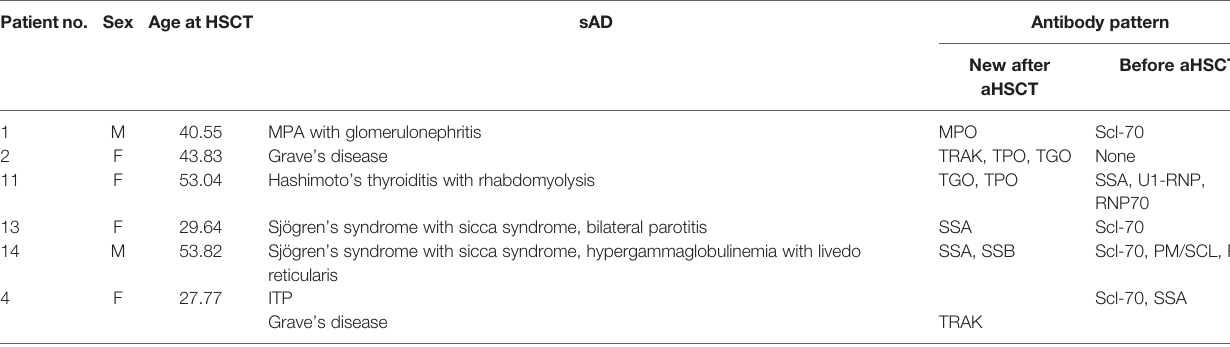
List of all patients with secondary autoimmune disorders sorted by sex, age at transplantation, mRSS before HSCT, new detected autoantibodies after aHSCT, and antibody pattern before aHSCT. M, male; F, female; mRSS, modi fi ed Rodnan skin score; MPA, microscopic polyangiitis; ITP, immune thrombocytopenic purpura; MPO, myeloperoxidase; TRAK, TSH receptor antibody; TPO, thyroid peroxidase antibody; TGO, thyroglobulin antibody; SSA, SSA(Ro) antibodies; SSB, SSB(LA) antibodies; RF, rheumatoid factor; aHSCT, autologous hematopoietic stem cell transplant.